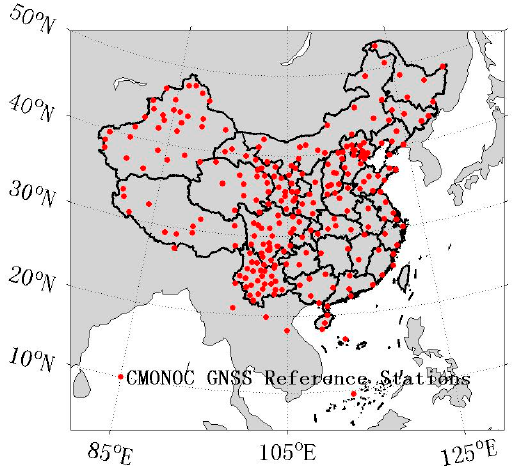
Figure 1. Distribution of CMONOC GNSS reference stations.